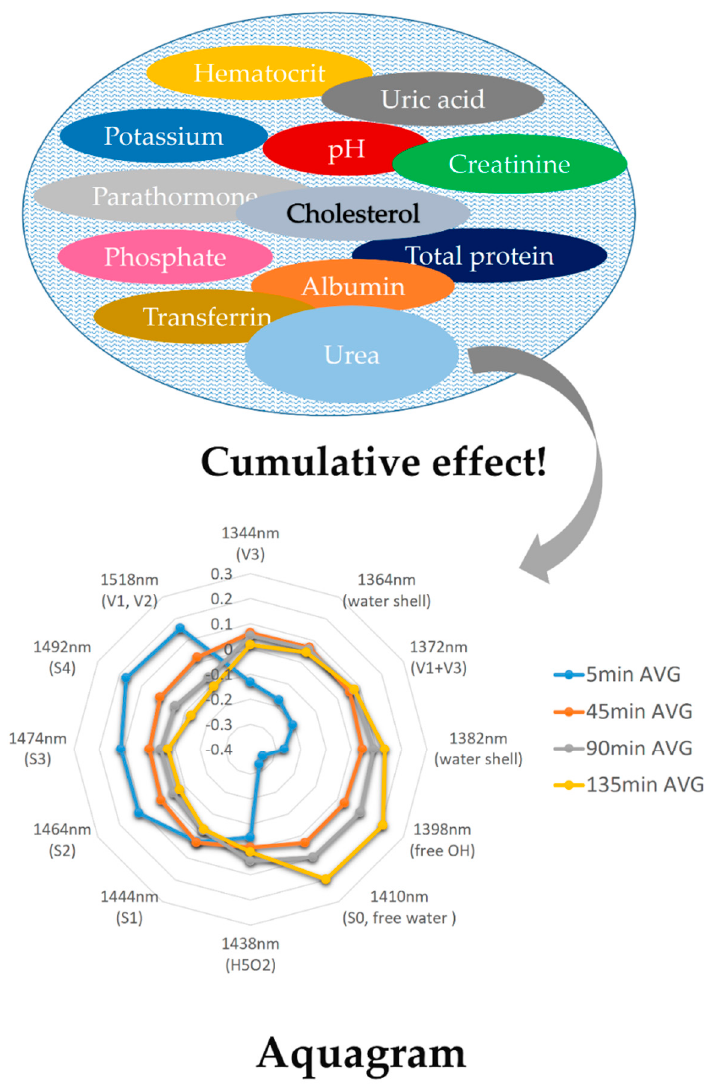
Figure 9. Water spectral pattern of spent dialysate presented on aquagram can be used as a marker of dialysis efficacy. Instead of measurements of different uremic toxins (of which there are more than 80), aquaphotomics provides measurement of their collective cumulative effect on water matrix of spent dialysate. [67].